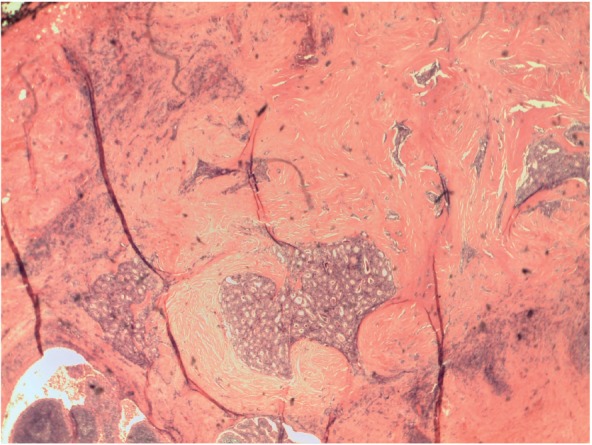
Papillary carcinoma sclerosing variant.